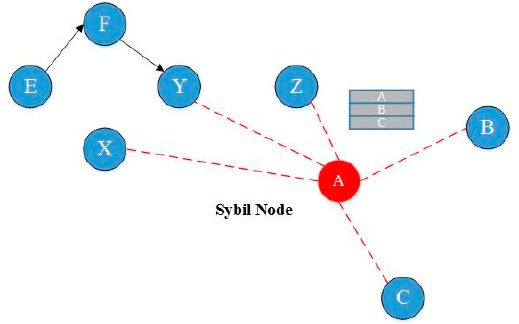
Figure 16. Sybil attack on WSN [10,87].